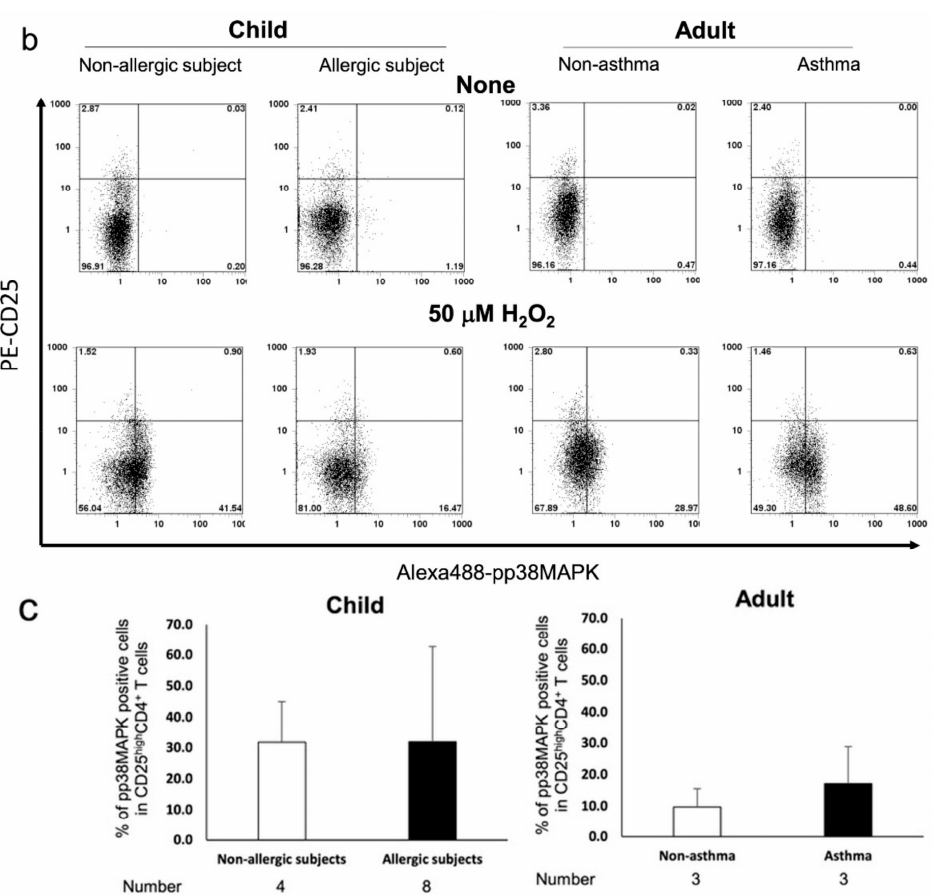
Figure 2. Flow cytometric measurement of p38 MAPK phosphorylation in response to H 2 O 2 exposure in CD4 + CD25 high T cells from paediatric and adult subjects. 3 × 10 5 PBMCs were incubated for 10 min and stained with PC5-CD4, PE-CD25, and Alexa 488-pp38 MAPK. Representative flow histograms from paediatric subjects without allergy and adult subjects without asthma are shown ( a ). Phosphorylation of p38 MAPK in cells exposed to 50 µ M H 2 O 2 or vehicle were compared between paediatric subjects with and without allergy and adult subjects with or without asthma. Representative flow histograms ( b ) and average percentage of pp38 MAPK-positive cells are plotted by bar graphs ( c ). Gating was performed on cells highly expressing CD25 antigen.